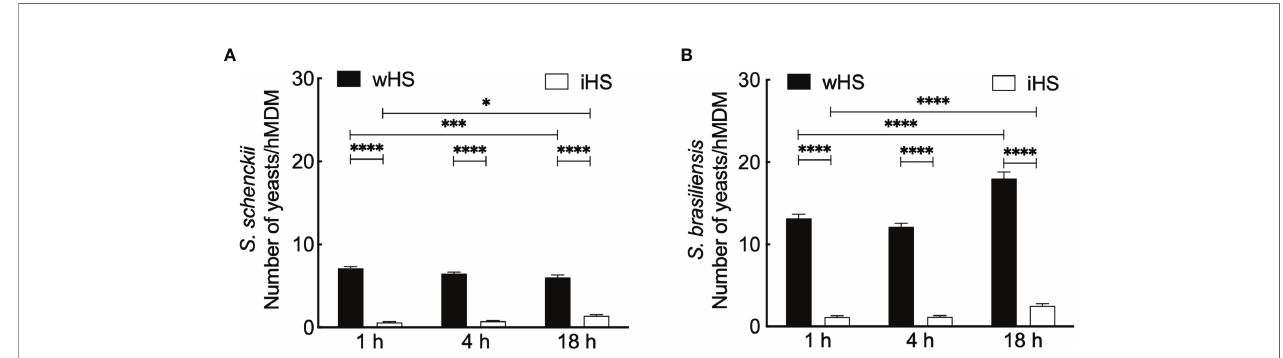
FIGURE 2 | Kinetics of the interaction between Sporothrix and human monocyte-derived macrophages (hMDMs). (A) Sporothrix schenckii or (B) Sporothrix brasiliensis yeasts were made to interact with hMDMs at 37°C in a CO 2 incubator for 1, 4, and 18 h in medium containing human serum [whole (wHS) or inactivated (iHS)]. Mean ± SEM of the yeasts internalized by hMDMs after indicated interaction period for which at least 10 optical microscopy fi elds were analyzed; a minimum of 50 hMDMs were counted for internalized yeasts; three biological replicates, in duplicate, were performed. Statistical analysis was performed by ANOVA with Tukey ’ s multiple comparison posttest (****p < 0.0001, ***p < 0.001, and *p